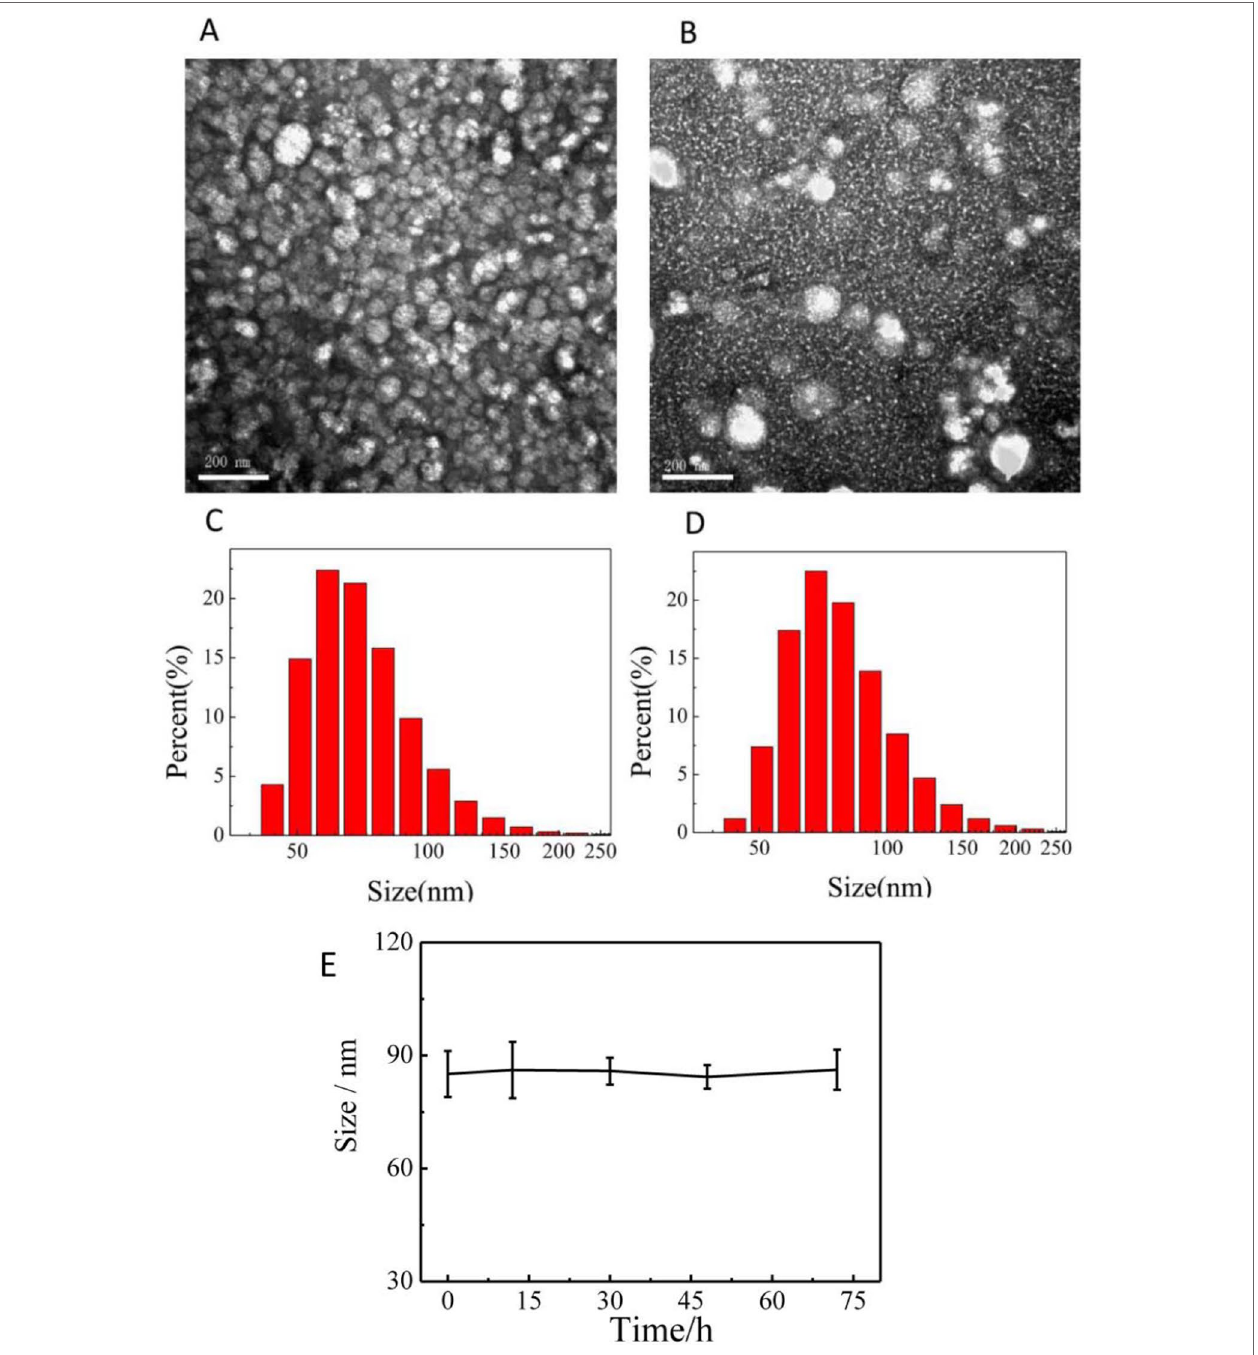
FIGURE 2 | The characterization of nanoparticles dispersed in PBS. (A) the TEM of PCL-PDEM, (B) the TEM of PCL-PDEM/QDs, (C) DLS of PCL-PDEM, and (D) DLS of PCL-PDEM/QDs; (E) monitoring of the size change of the PCL-PDEM/QD nanoparticles in PBS at indicated time points by DLS measurement. Scale bar: 200